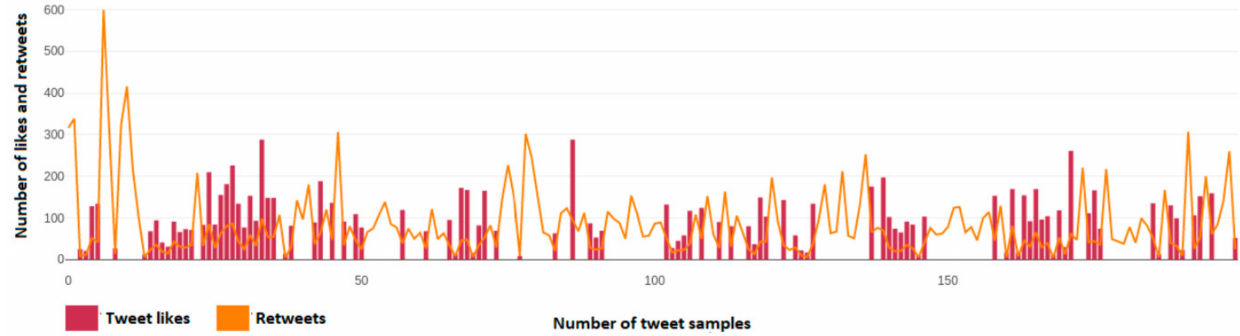
Figure 15. Number of likes and retweets per tweet for @syriza_gr (200 tweet sample). Figure 16 depicts the number of user reactions, likes, and retweets of each tweet from a dynamic sample of 200 tweets taken from the official Movement for Change (@kinimallagis) political party account on Twitter. This political party is commonly known as KINAL and on the last Greek legislative elections of June 2019 received the lesser Parliamentary opposition former Prime Minister of the Hellenic (Greek) Republic from September 2015 until June 2019. Axis y depicts the number of likes and retweets that a single tweet has, while the x axis depicts the number of each tweet over this 200-tweet sample.